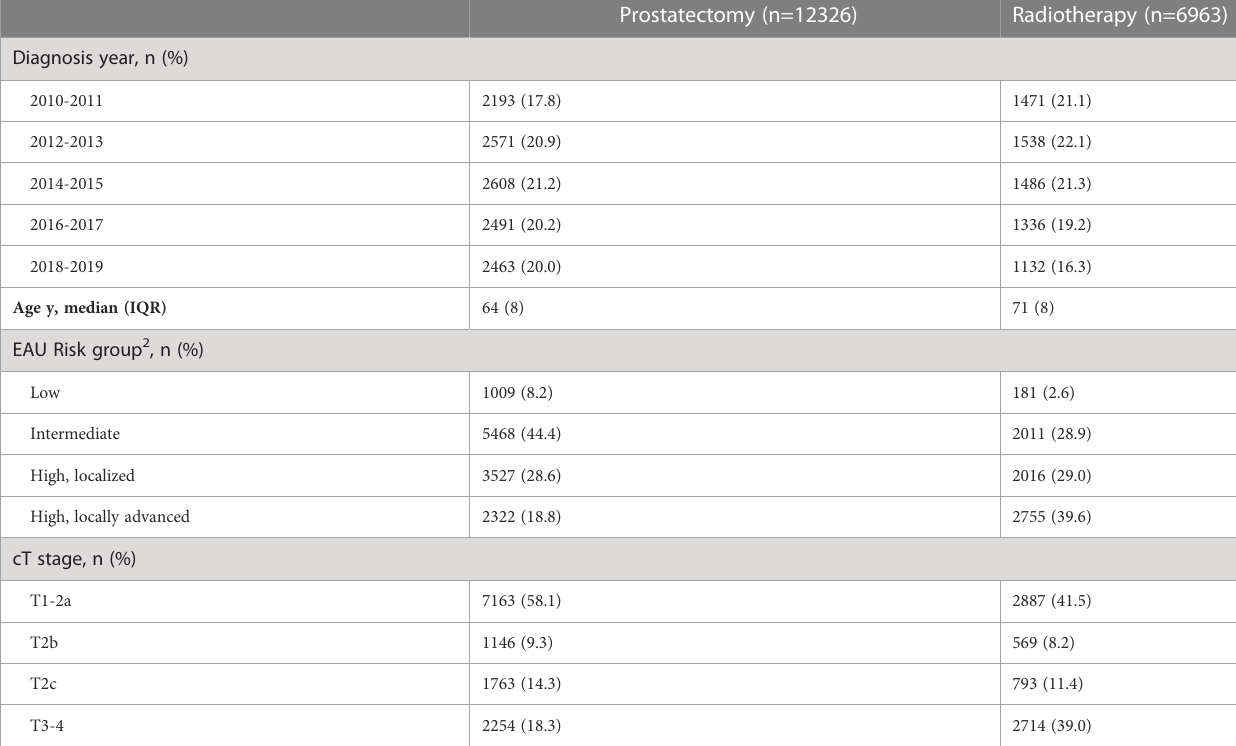
TABLE 1 Baseline characteristics 1